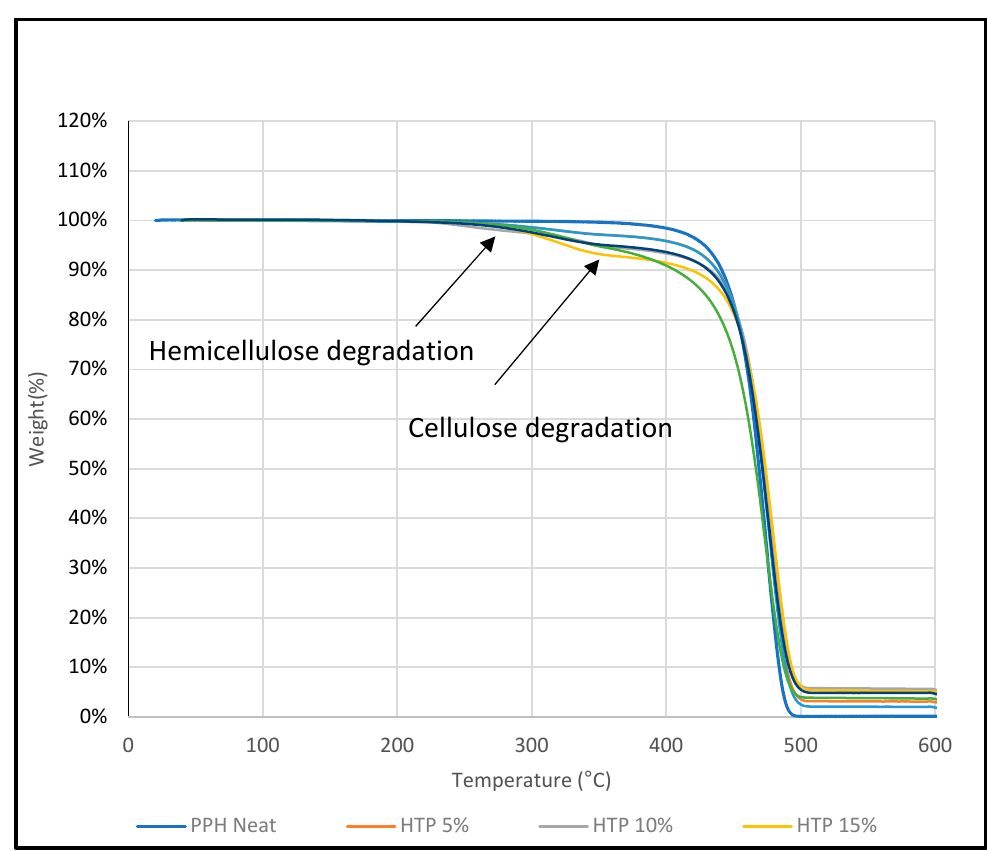
Figure 11. TGA of homo polypropylene-treated fiber composites.